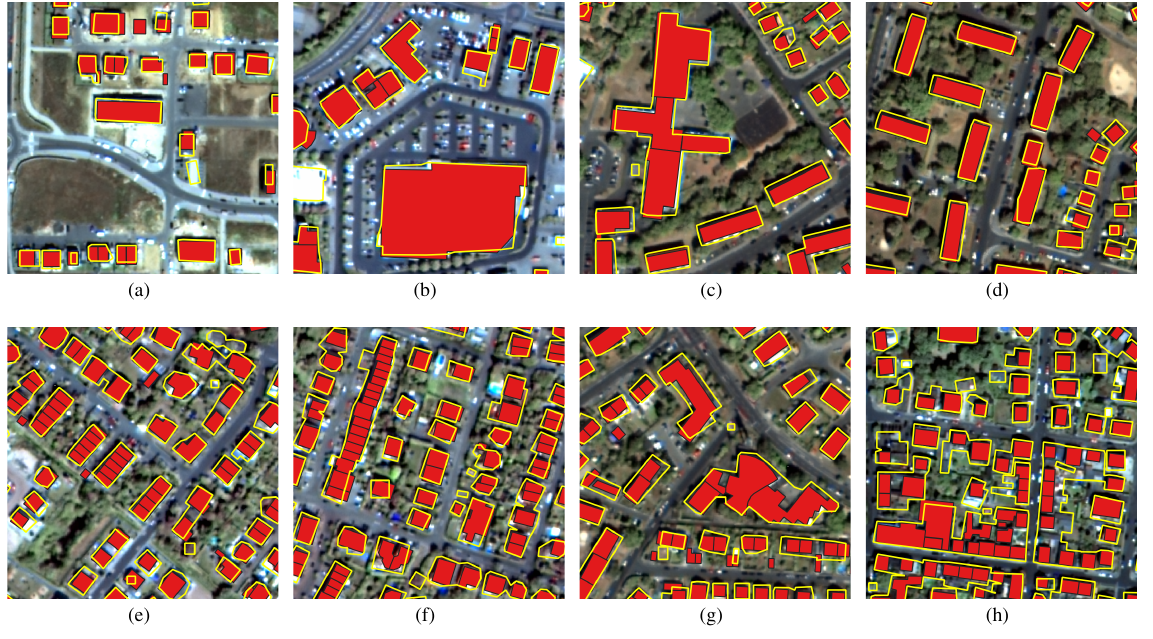
Figure 2. Building extraction results in yellow and the reference masks (red) overlaid on orthophotos.